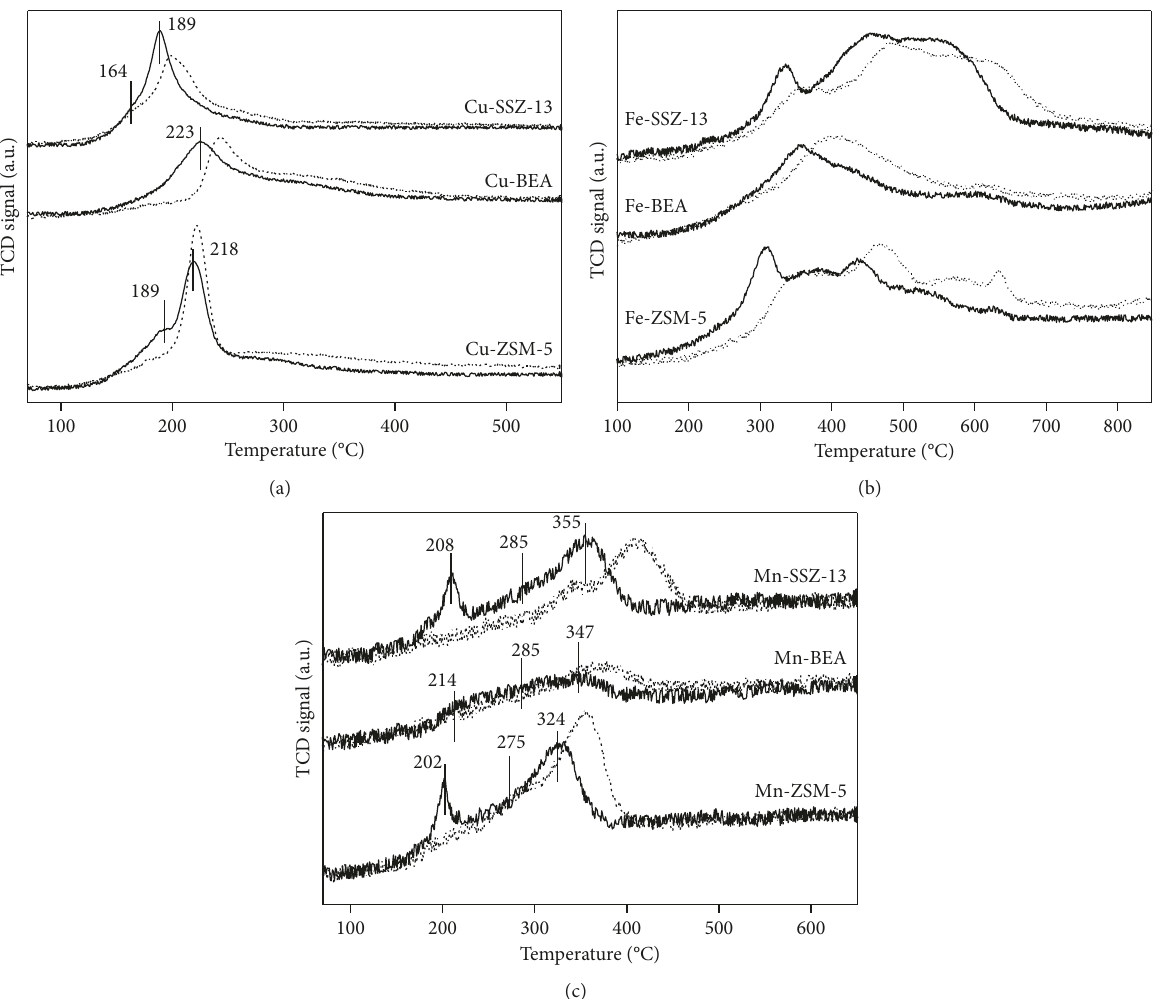
Figure 3: H 2 -TPR profiles of fresh and hydrothermally treated (dotted line) (a) Cu-, (b) Fe-, and (c) Mn-zeolite